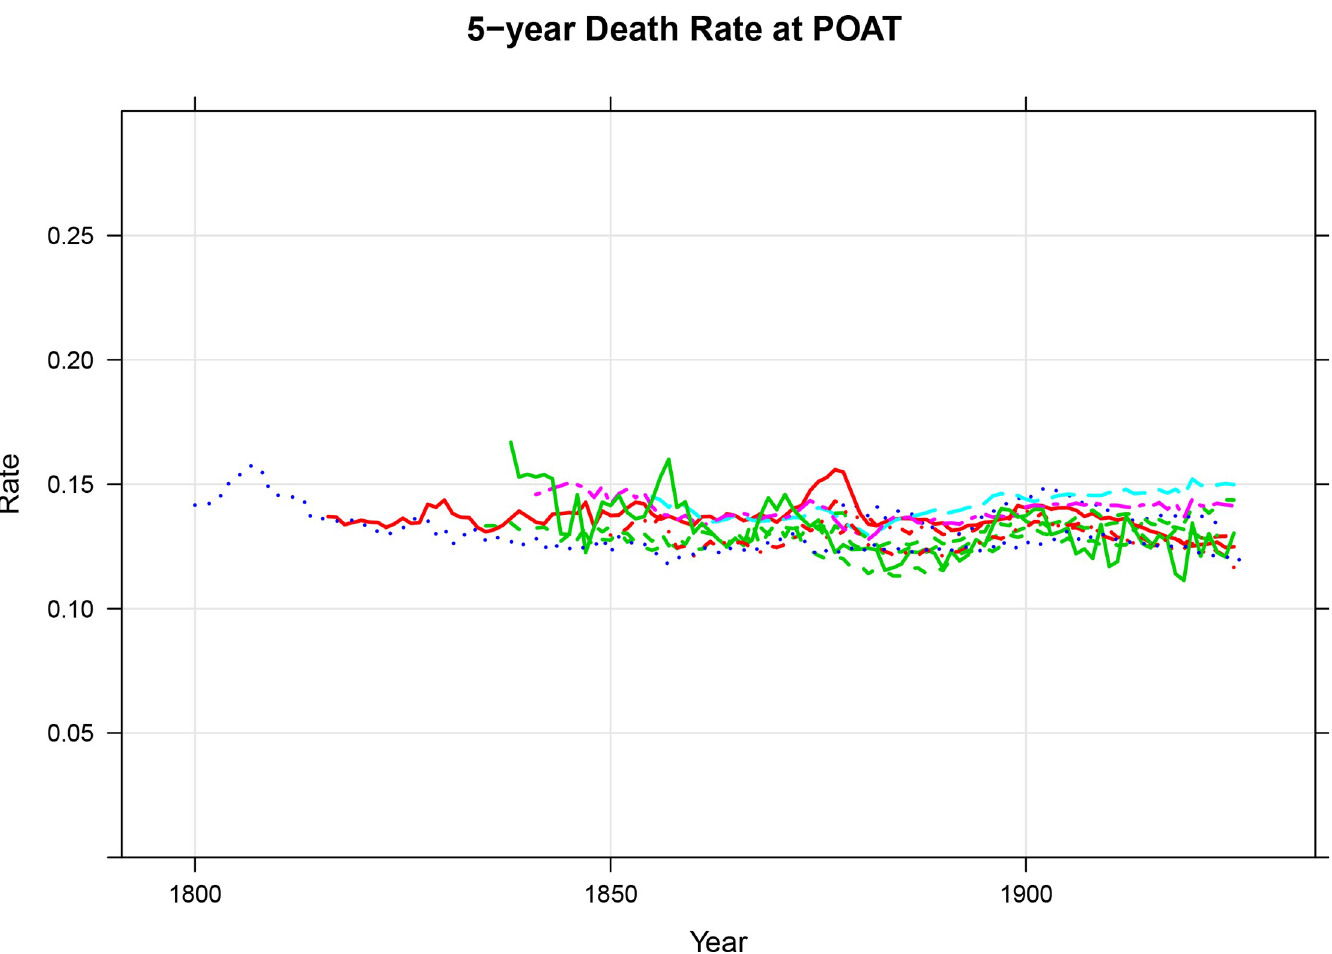
Fig 4. 5-Year death rates at the prospective old age threshold, 1830 to the latest observation, cohort life tables from Denmark, England and Wales, Finland, France, Iceland, Italy, the Netherlands, Norway, Scotland, Sweden, and Switzerland, both sexes combined. Source: Human Mortality Database [9] and Authors’ Calculations. Underlying data are presented in the Supplementary